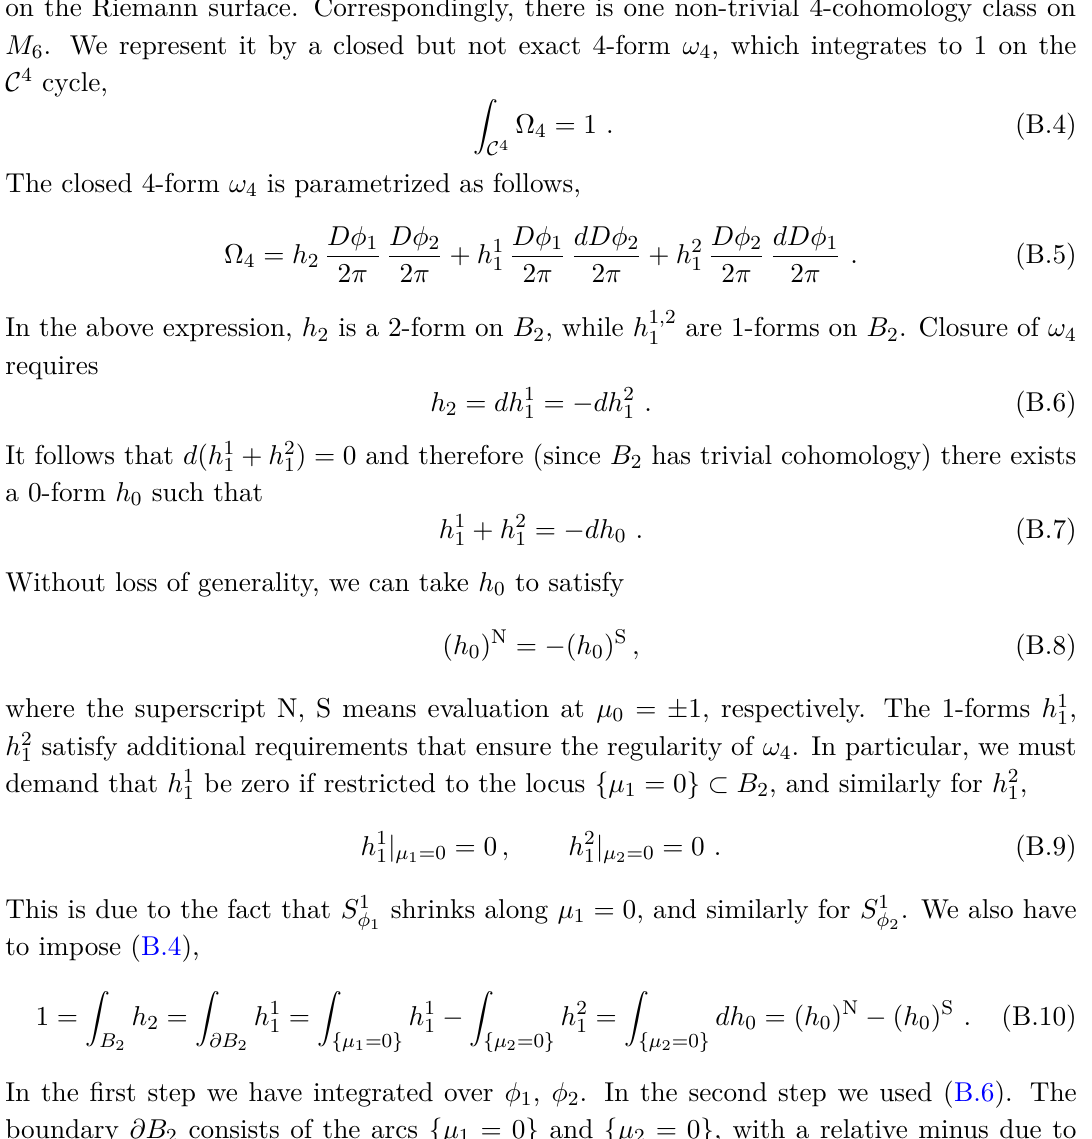
used throughout this 2